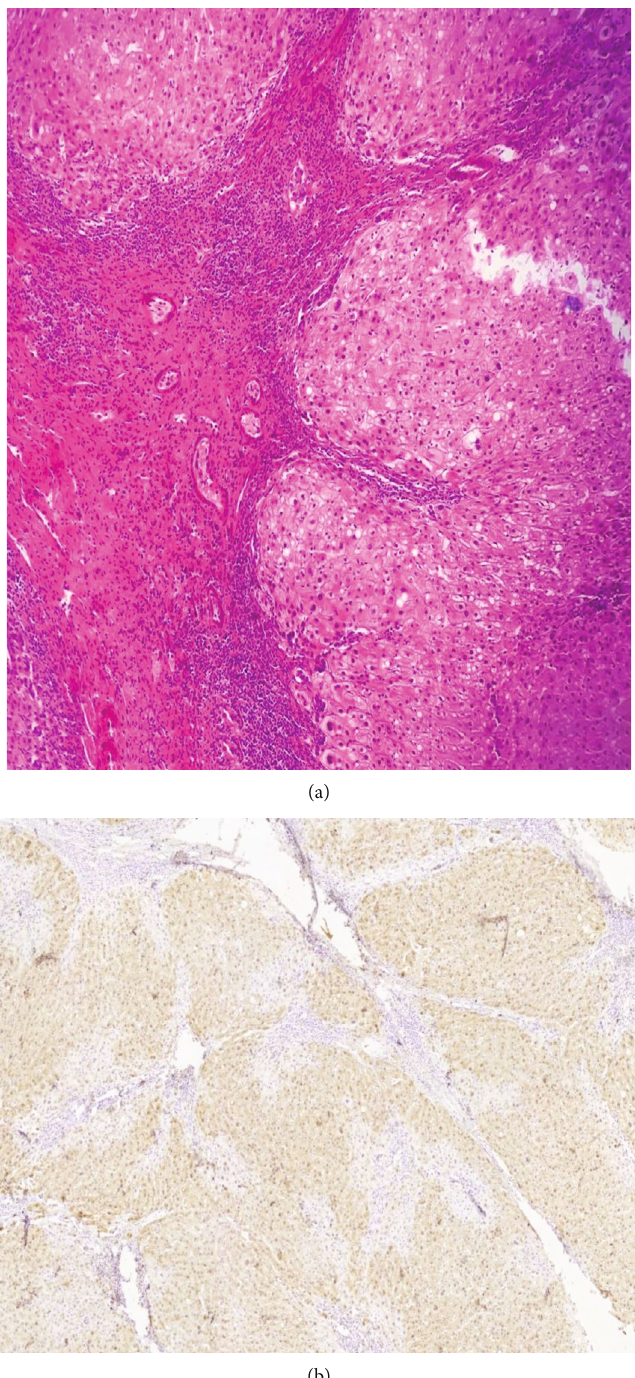
Figure 3: (a) Bland hepatocytes surrounded by fi brous septa that contain artery branches and variable degree of ductular reaction ( × 100, H&E). (b) Immunohistochemistry study for glutamine synthetase (GS) showing a map-like pattern of positivity in hepatocytes ( ×